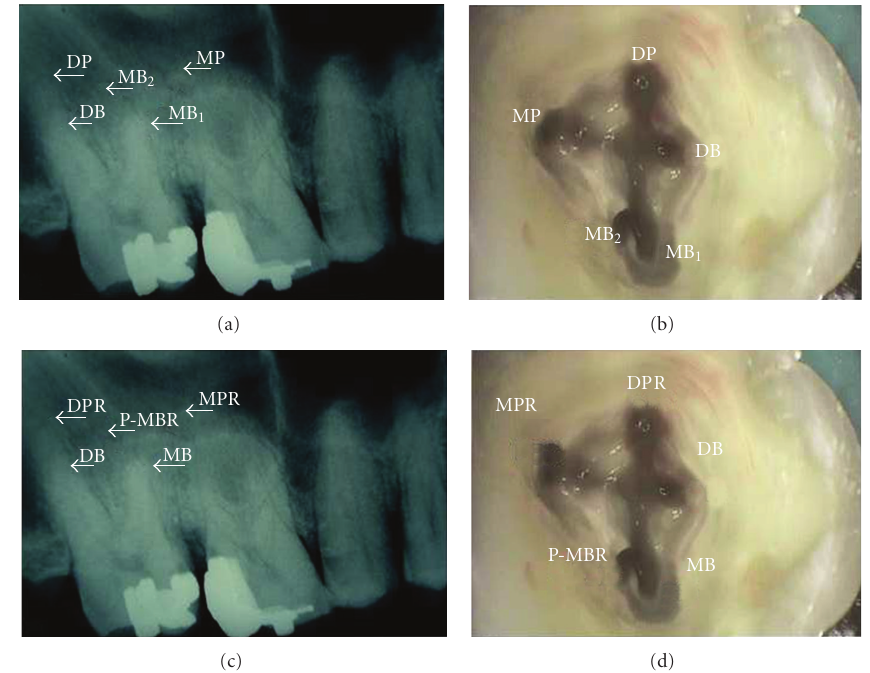
Figure 4: (a) Radiograph showing the root morphology of five separate roots named using the traditional terminology. MB: mesiobuccal, DB: distobuccal, DP: distopalatal, and MP: mesiopalatal. (b) Access opening picture of the same tooth showing the names of the canals as per the traditional approach, wherein each root has a single canal. (c) Radiograph, as seen in (a), with designation of roots according to their anatomical positions as per the proposed nomenclature. “ R ” signifies the presence of an additional root. P-MBR : palato-mesiobuccal root, MPR : mesiopalatal root, and DPR : distopalatal root. (d) Picture, as seen in (b), with naming of canals according to the recommended nomenclature. (Reprinted with permission from Kottoor et al.